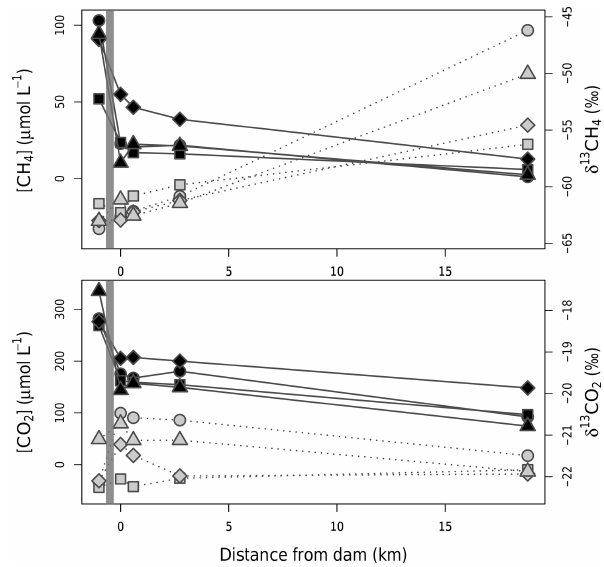
Figure 3. Concentrations (black symbols and solid line) and δ 13 C (grey symbols and dotted lines) of CO 2 and CH 4 from right up- stream of the dam (grey band) to 19km downstream in the out- flow river. Circles, squares, diamonds, and triangles represent val- Mar 2018, and August 2018